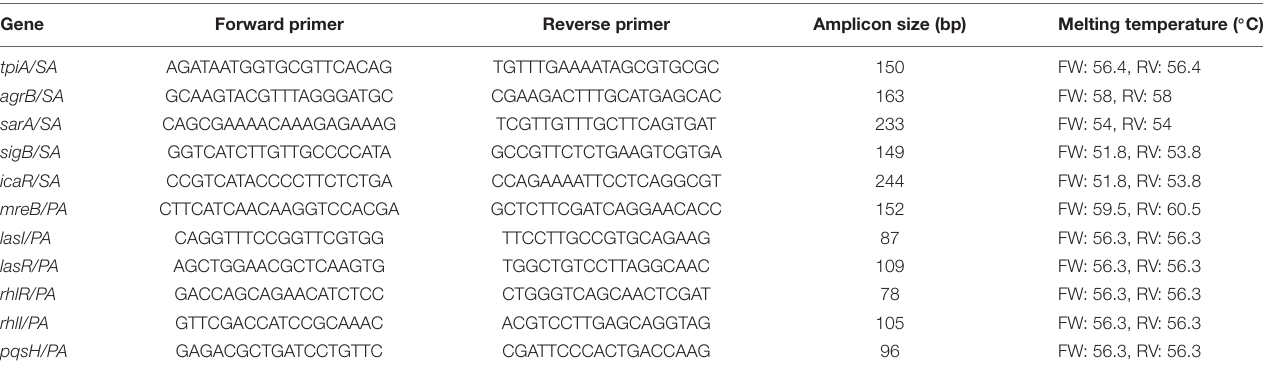
TABLE 1 | Primers used in this